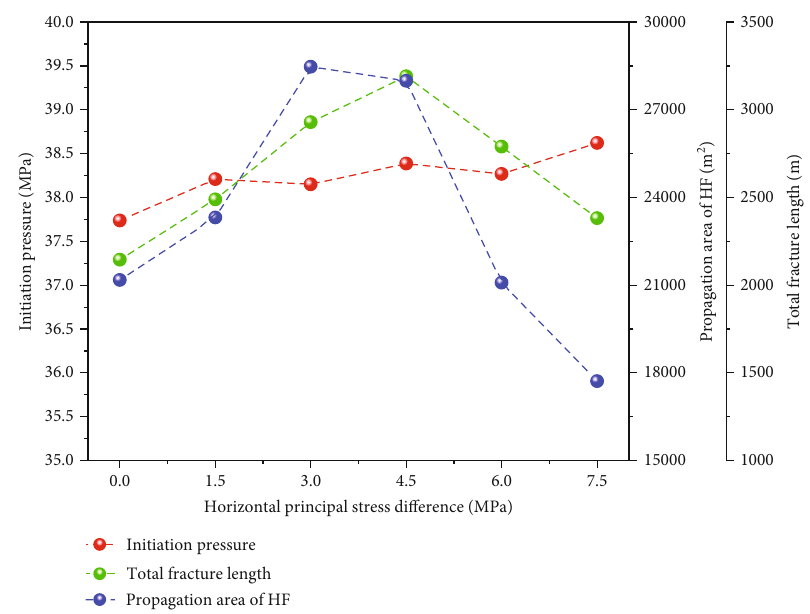
Figure 17: Total equivalent hydraulic fracture length and propagation area of the complex fracture network.